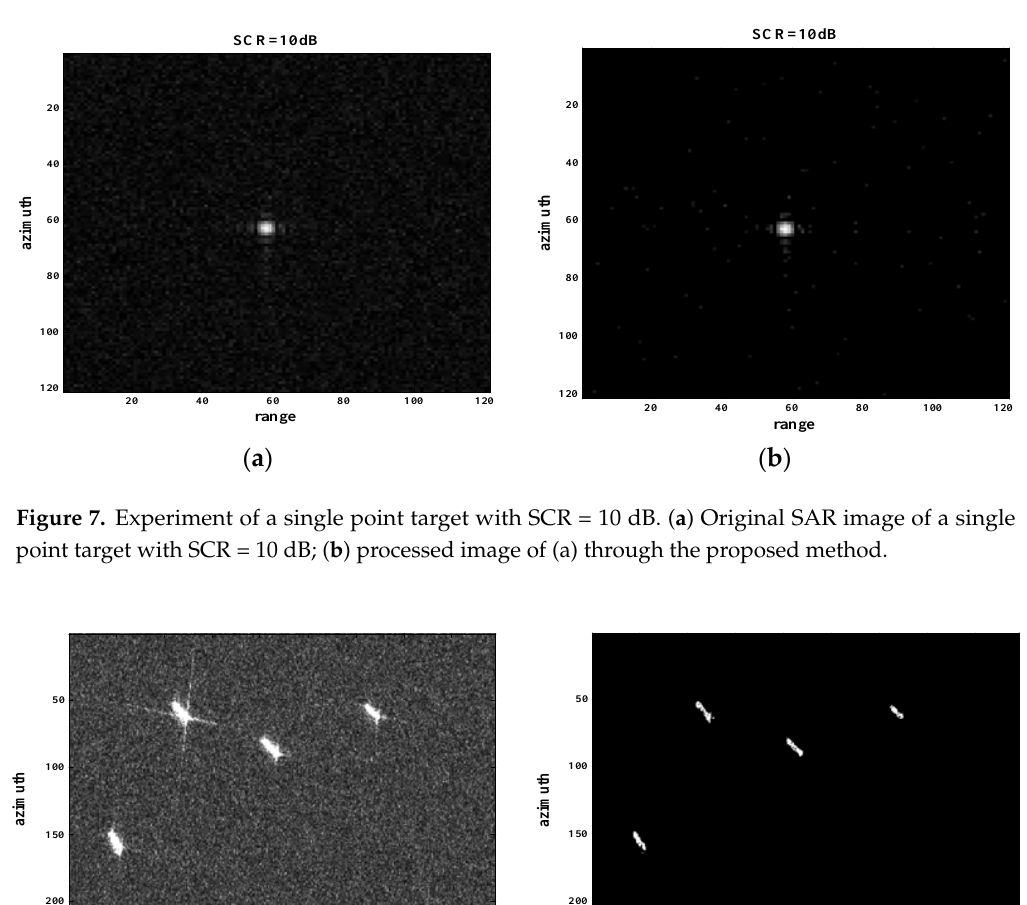
Figure 7. Experiment of a single point target with SCR = 10 dB. ( a ) Original SAR image of a single point target with SCR = 10 dB; ( b ) processed image of (a) through the proposed method.